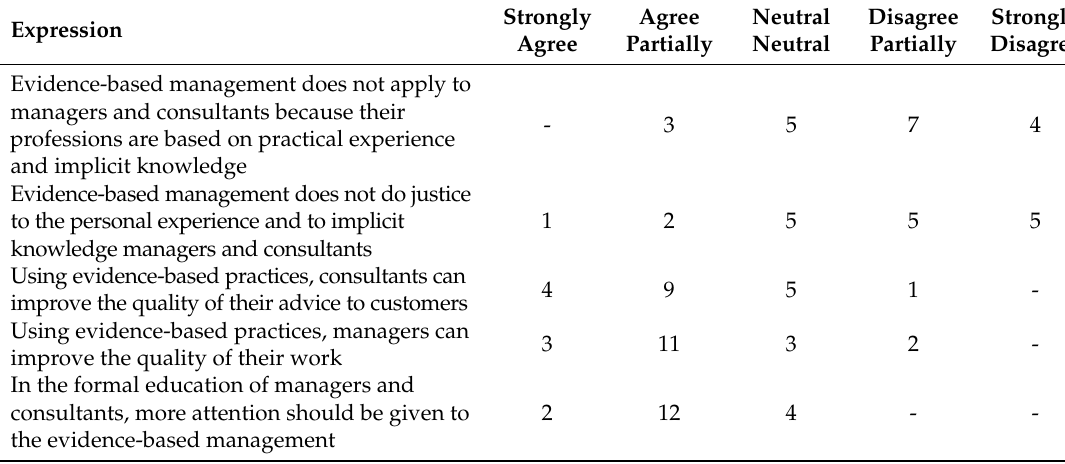
Table 7. Current attitudes towards